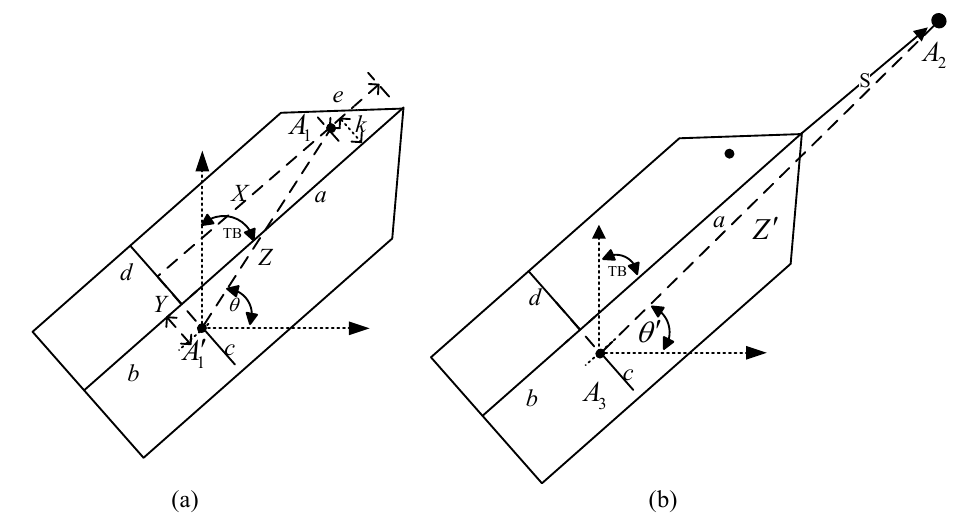
Figure 6. Schematic diagram of the position deviation of ship position sensors. ( a ) The position deviation of ship position sensors when anchoring. ( b ) The position deviation of ship position sensors after anchoring.